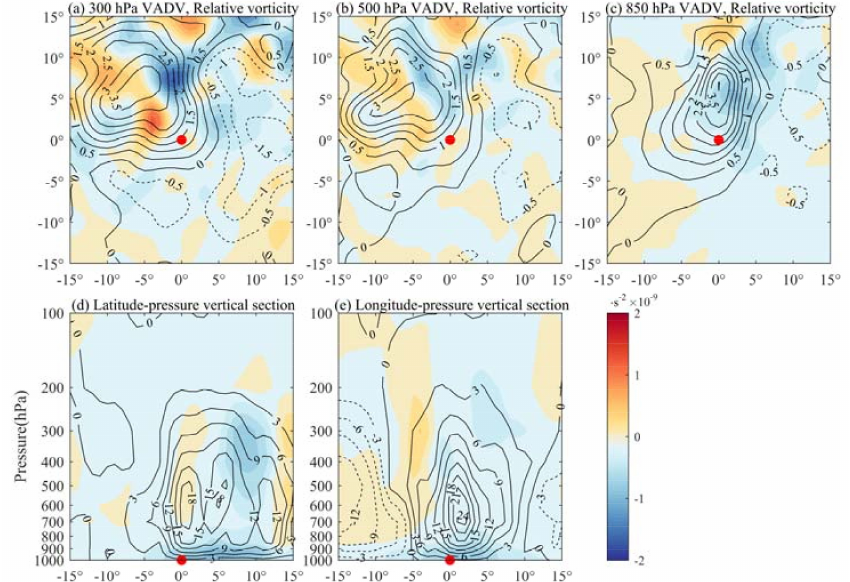
Figure 10. Composite horizontal distribution of relative vorticities (contours, unit: 10 − 5 s − 1 ) and the vorticity advection induced vorticity change (the VADV term, color shading, unit: 10 − 9 s − 2 ) in the cyclone region at the 300 hPa ( a ), 500 hPa ( b ) and 850 hPa ( c ), respectively, under the cyclone centered coordinate, and vertical sections of the vertical velocities (contours, unit: − 1 hPa/s) and the vorticity advection induced vorticity change (the VADV term, color shading, unit: 10 − 9 s − 2 ) along the 0 ◦ latitude ( d ) and 0 ◦ longitude ( e ) in the cyclone centered coordinate, based on the selected cyclones in the Northwest Atlantic. The red spot is the center of the extratropical cyclone at the sea level.